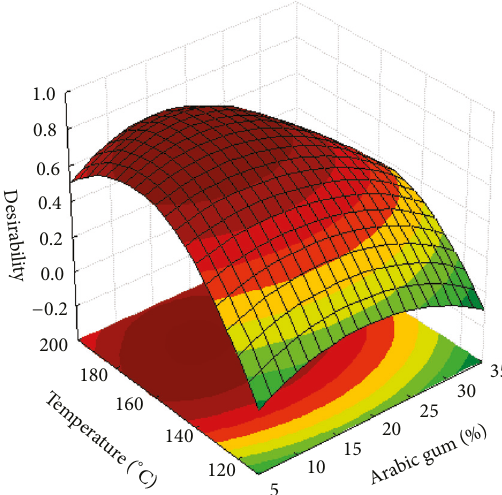
Figure 6: Desirability surface for optimal